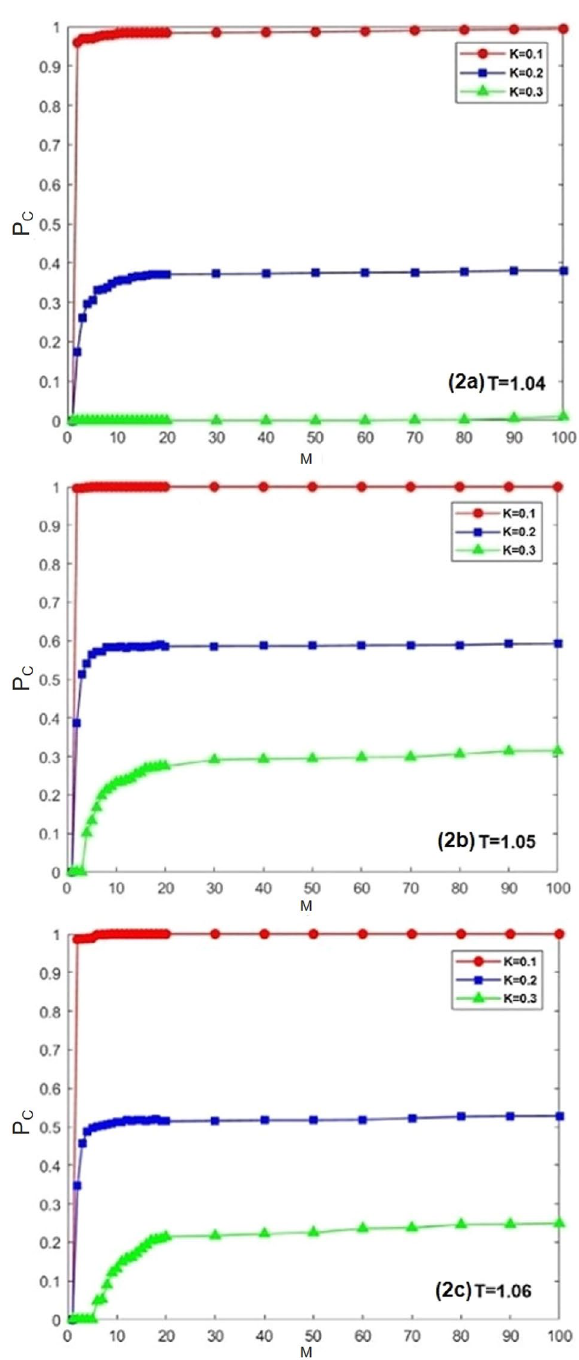
Figure 2. Evolution of cooperation rate with M under different K ( K = 0.1, 0.2, 0.3 ) and T ( T = 1.04, 1.05, 1.06 ). The lattice size is set to be L × L = 200 × 200 , β